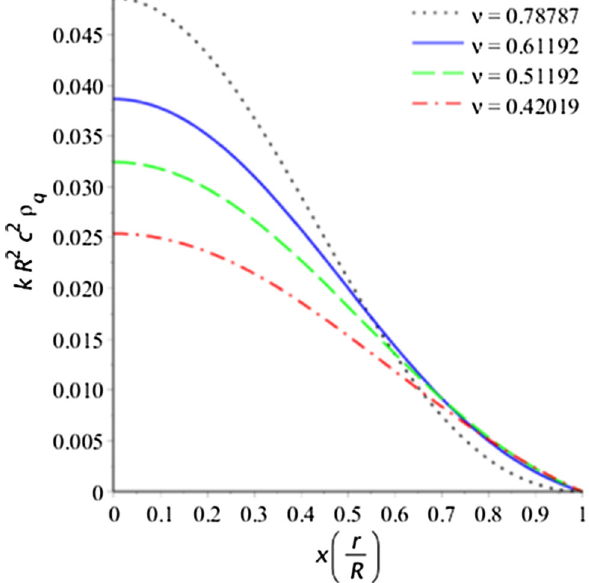
Fig. 4 Graphical representation of tangential pressure for w = − 0 .